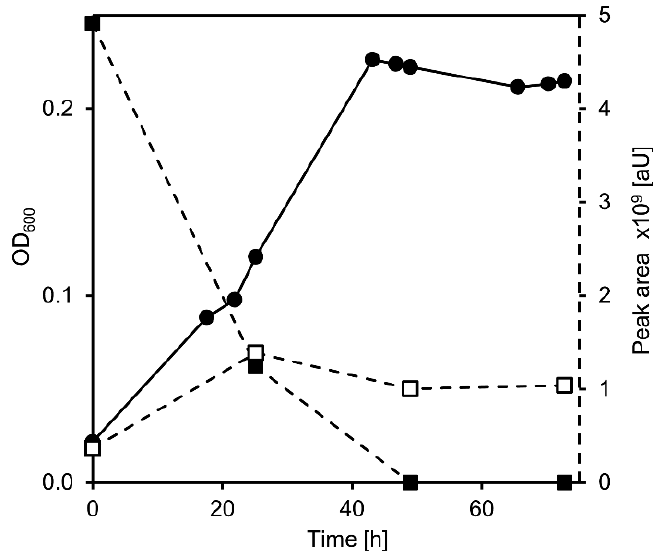
Figure 5. Growth of Sphingobium sp. strain Chol11 with DHSATD (XI in Figure 1, filled circles), degradation of DHSATD (filled squares, second axis), and accumulation of MDTETD (XIII, open squares, second axis) during growth with DHSATD. Error bars indicate standard deviation, which may not be visible if too small ( n = 3).